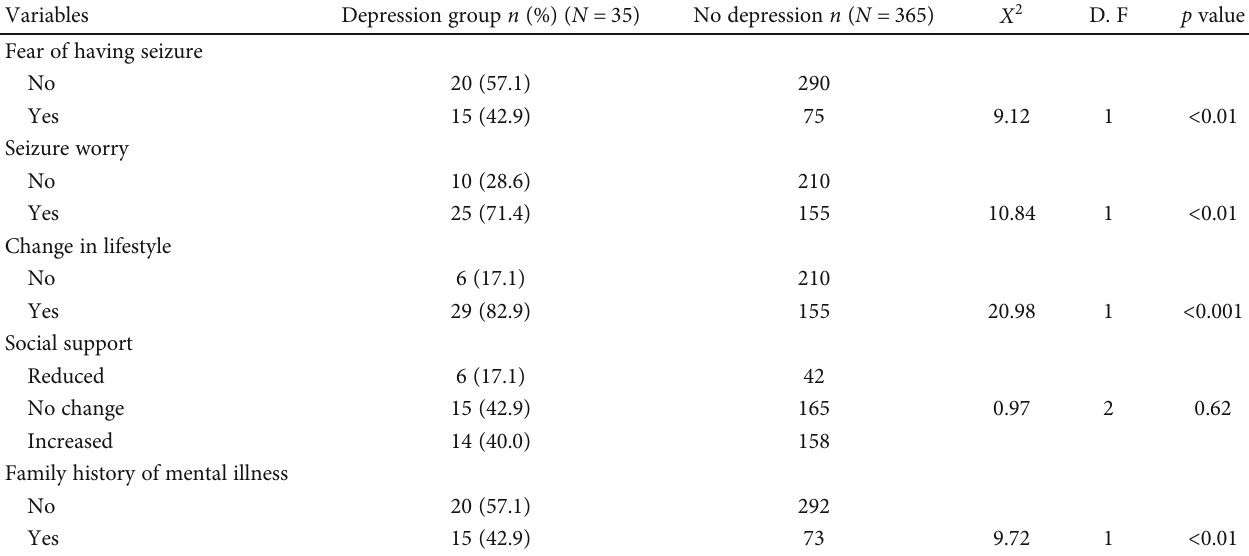
Table 2: Comparison of the psychological characteristics of the study participants in the depressed and nondepressed groups ( n = 400 ).